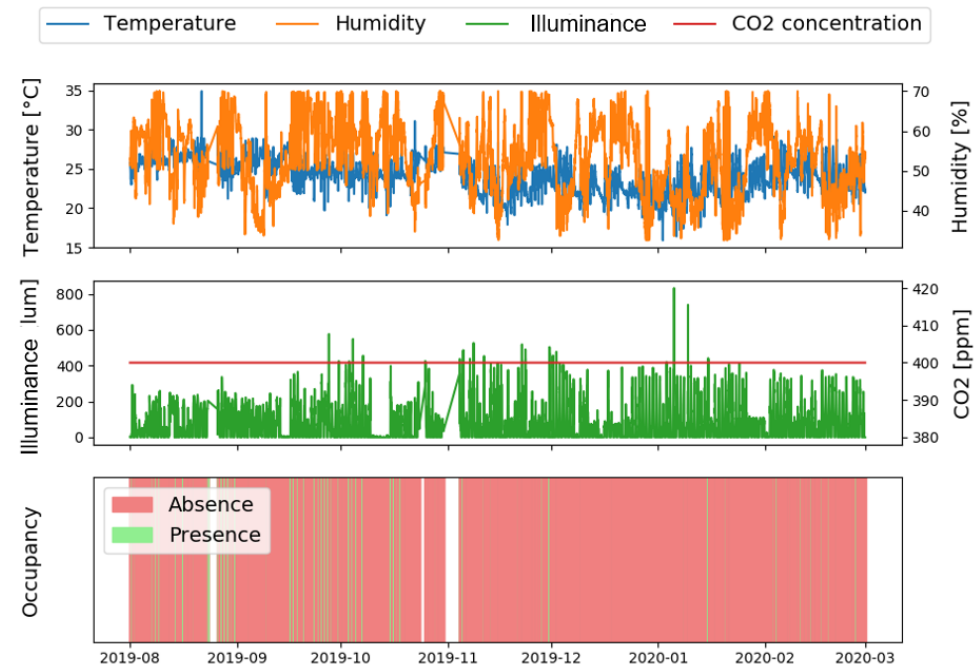
Figure 5. Results of unsupervised Occupancy Forecasting app on selected part of test dataset.